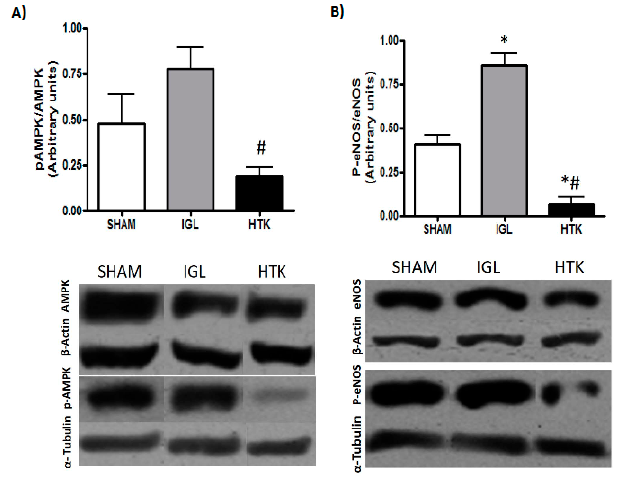
Figure 5. p-AMPK/AMPK ( A ) and p-e-NOS/e-NOS ( B ) protein levels in steatotic liver grafts preserved in IGL-1 and HTK solutions vs. SHAM. Results are expressed as mean ± SEM ( n = 6). ( A ) # p < 0.01 represent significant differences versus IGL-1. ( B ) # p < 0.01 represent significant differences versus IGL-1. * p < 0.01 represent significant differences versus SHAM.